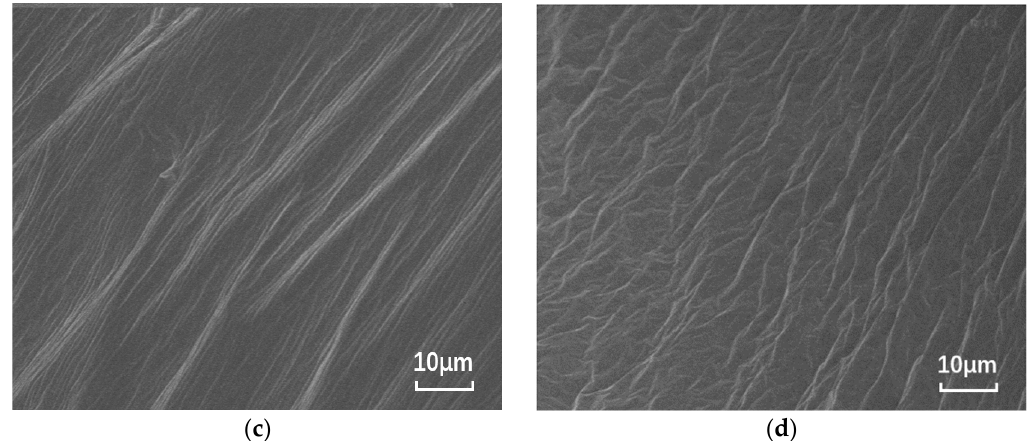
Figure 1. SEM images of different asphalt binders: ( a ) B0; ( b ) S0; ( c ) B5; and ( d ) S5.